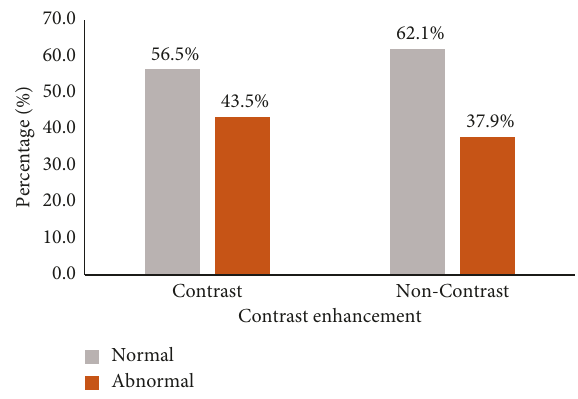
Figure 2: Rate of abnormal head CT findings among patients presenting with headache, 2017–2020. Table 2: Comparison of contrast CT and noncontrast CT head diagnosis of patients presenting with headache, 2017–2020.